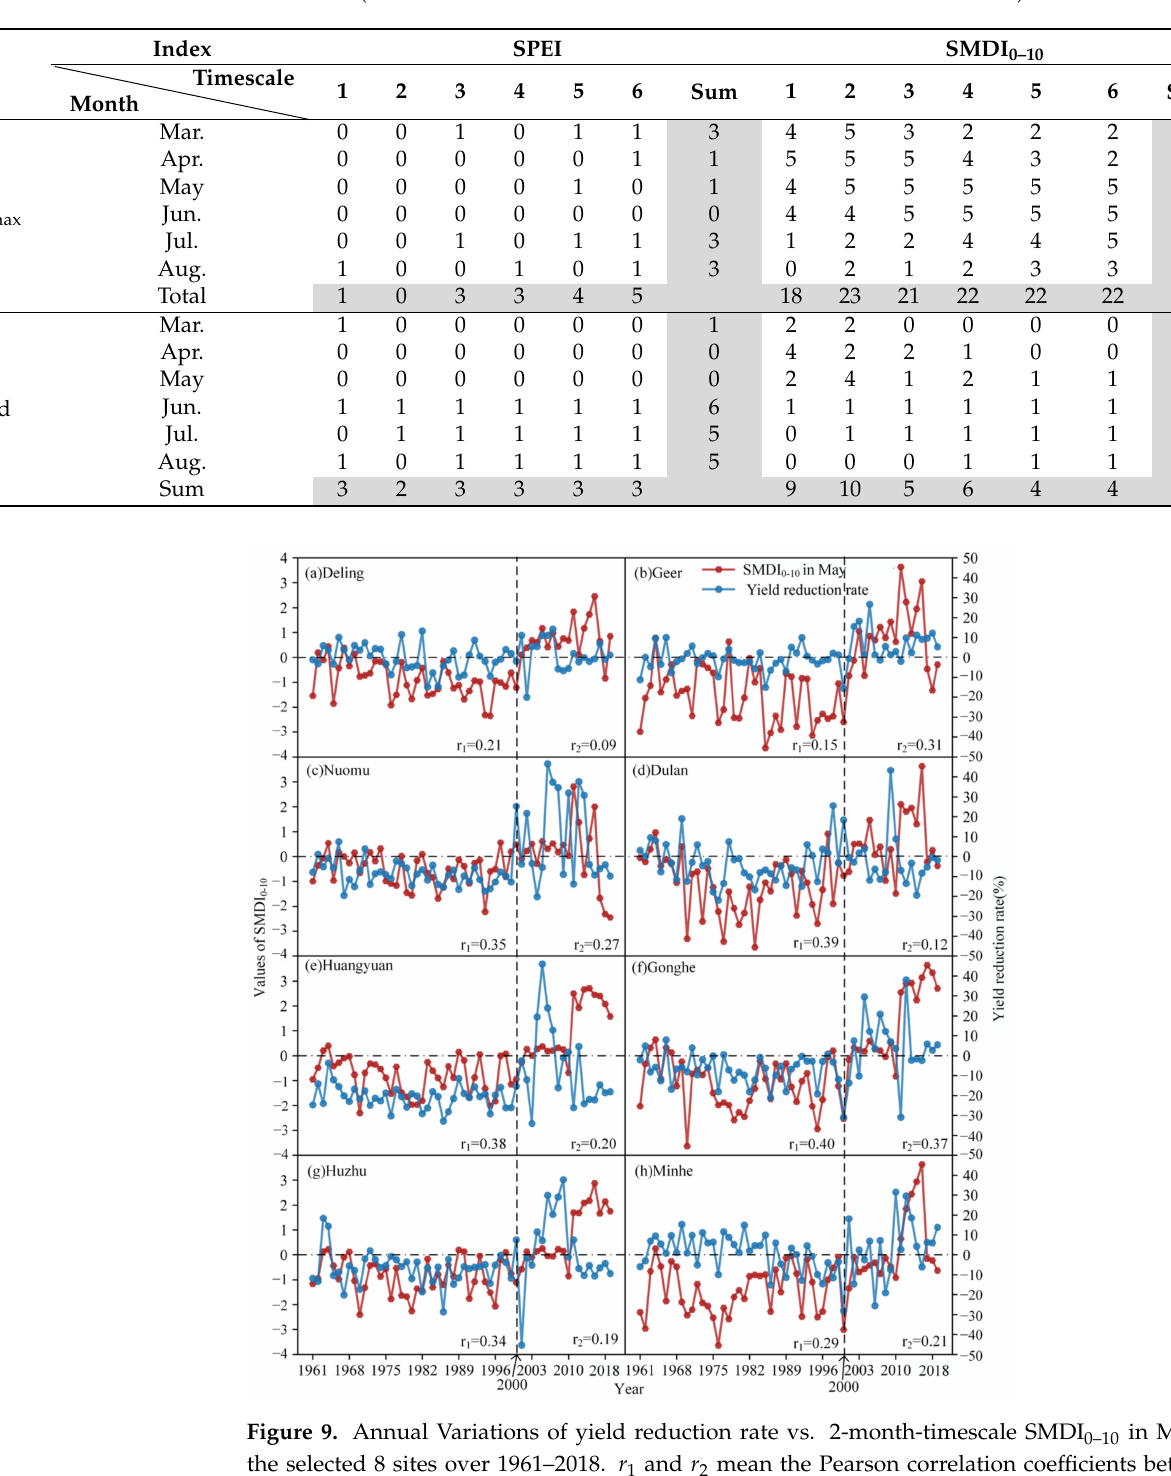
Figure 9. Annual Variations of yield reduction rate vs. 2-month-timescale SMDI 0–10 in May